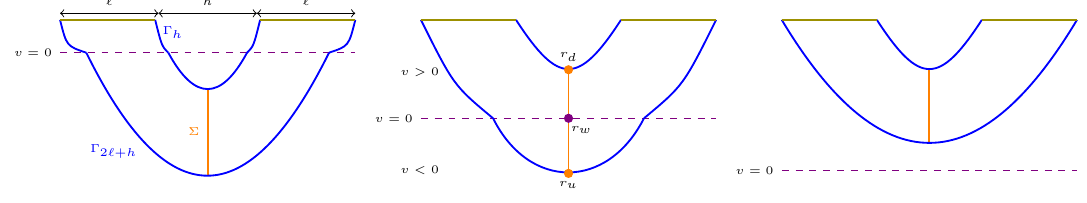
Figure 5 . Schematic con(cid:12)gurations for HRT ((cid:0)) and EWCS ((cid:6)) geodesics corresponding to sym- metric entangling regions on the boundary. Outside the null shell (indicated in dashed violet), i.e., v > 0, the geodesics propagate in an AdS black brane geometry, while inside, i.e., v < 0, they propagate in a pure AdS geometry. The null shell refracts the geodesics. Left : while at early times, the shell lies in the UV part of the geometry and (cid:0)’s cross the shell near the boundary, (cid:6) does not intersect the shell. Middle : during intermediate stages of time evolution (cid:0) 2 ‘ + h and (cid:6) cross the null shell. Right : at late time (cid:0)’s and (cid:6) do not intersect with the shell and lie entirely in black brane geometry.